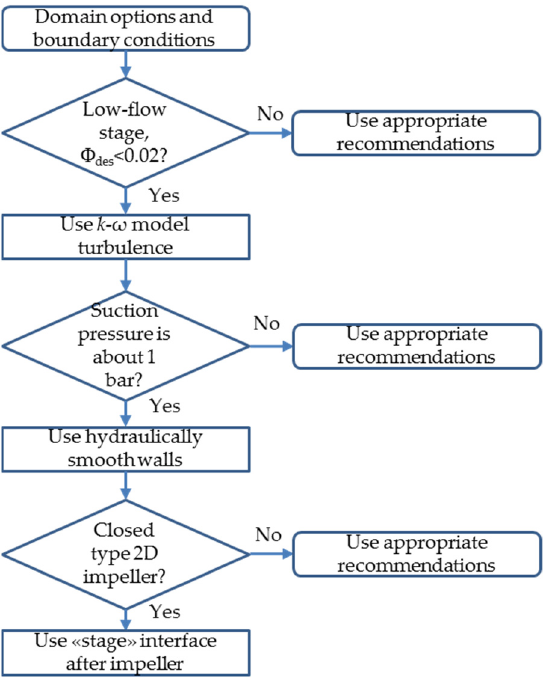
Figure 6. Recommendations flowchart for the low-flow stages with 2D closed type impeller.